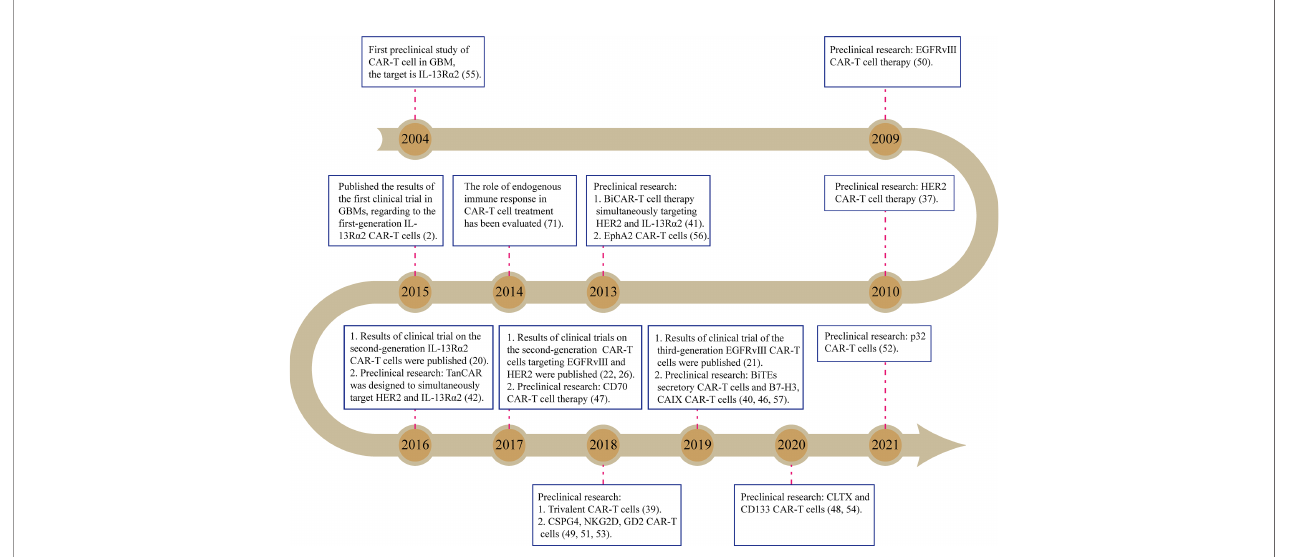
FIGURE 1 | The main course of developing CAR-T cell therapies on GBMs.